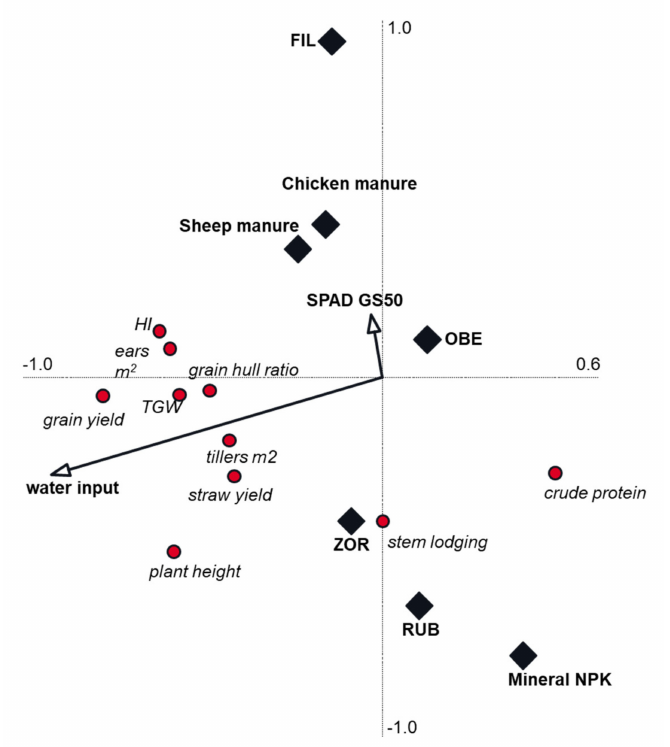
Figure 3. Biplot derived from the redundancy analysis showing the relationship between variety choice, fertilizer type, water availability 1 and N availability 2 explanatory variables/drivers and grain yield, stem lodging, crude protein content and yield-related growth parameters (harvest index [HI], plant height, tillers per m 2 , ears per m 2 , thousand grain weight [TGW], grain/hull ratio in spelt wheat. Fixed explanatory variables are shown as black diamonds ( (cid:7) ) and were: (a)